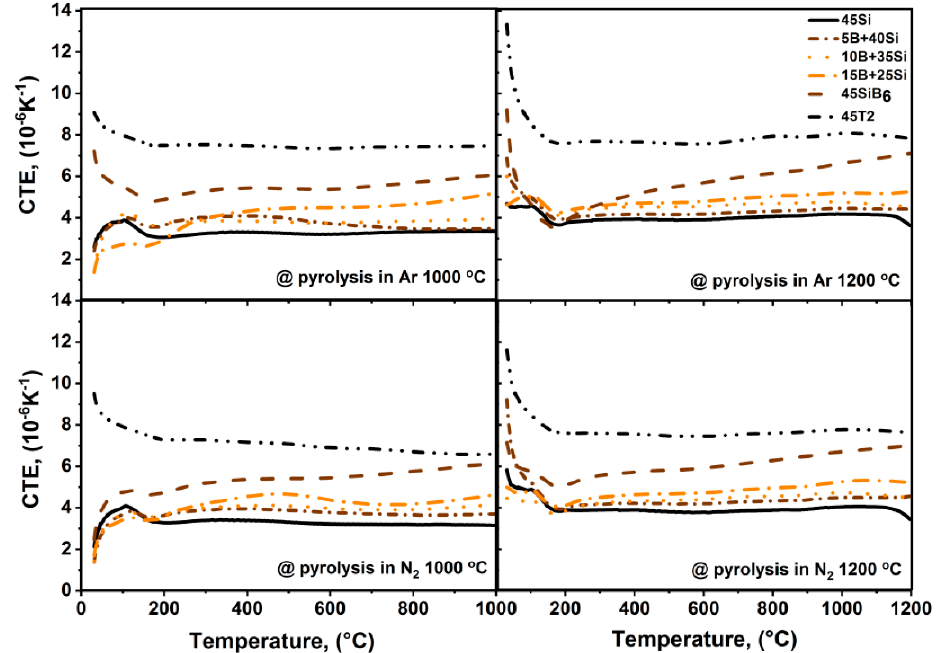
Figure 4. CTE values of bulk samples of the filler loaded coating systems after pyrolysis in Ar and in N 2 at 1000 °C and 1200 °C.